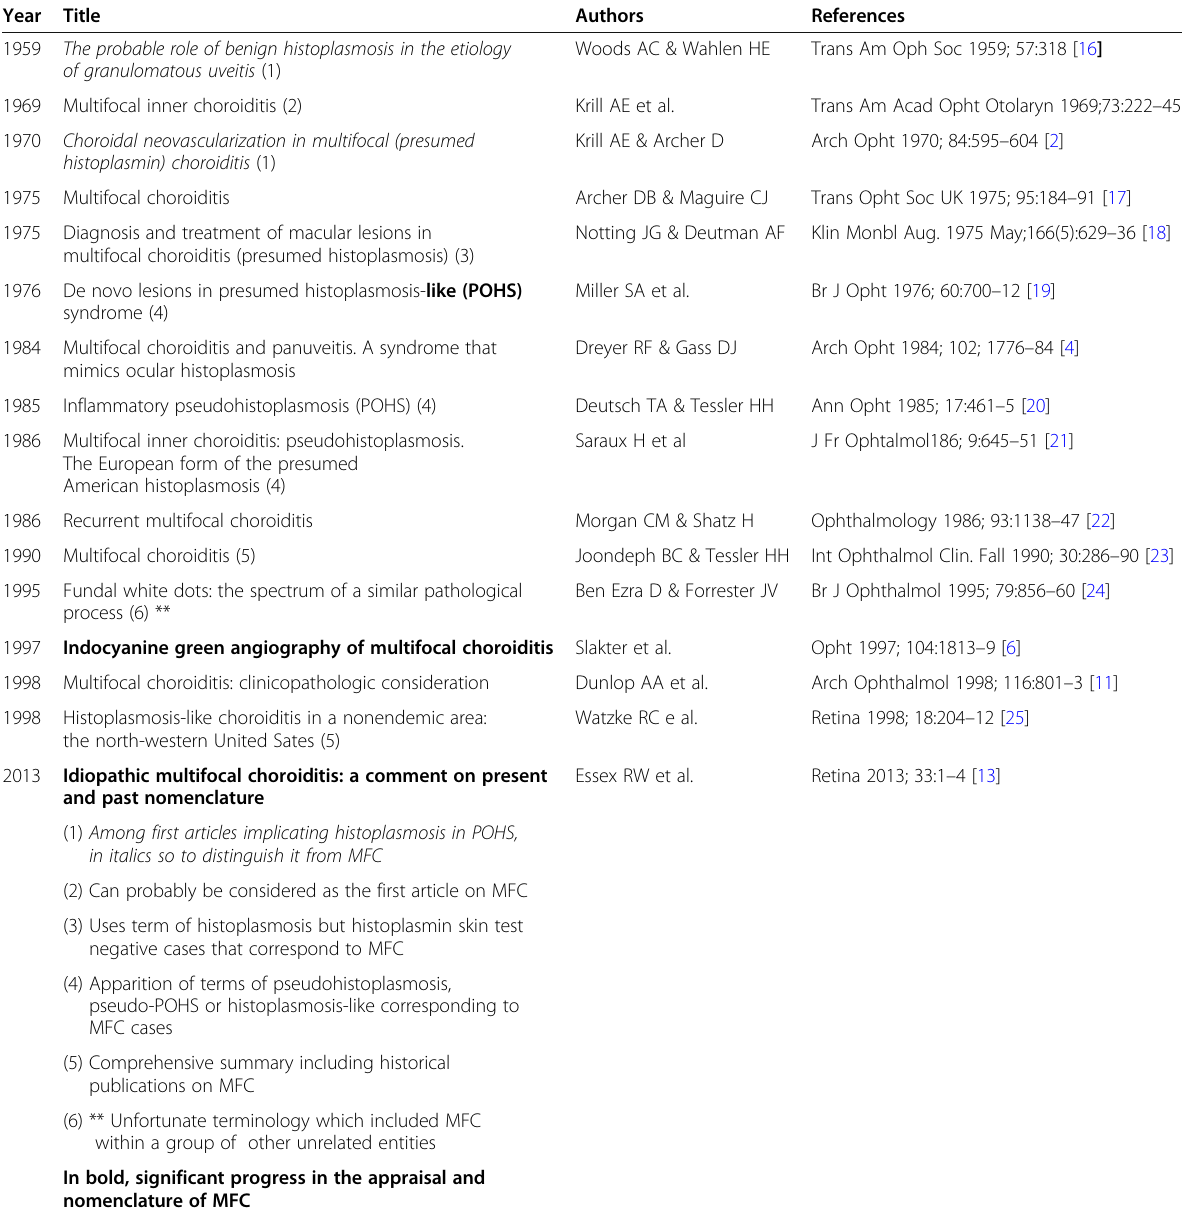
Table 1 Chronology of significant publications corresponding to today ’ s (idiopathic) multifocal choroiditis and those that